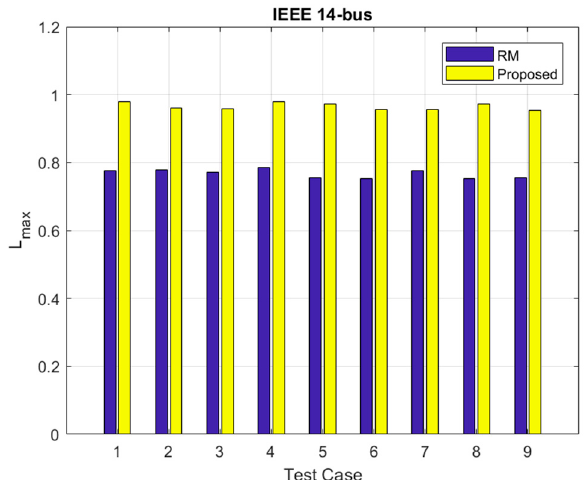
Figure 9. Comparisons for system load at voltage collapse point under different test cases in IEEE 14-bus model. A higher max L indicates a better performance.